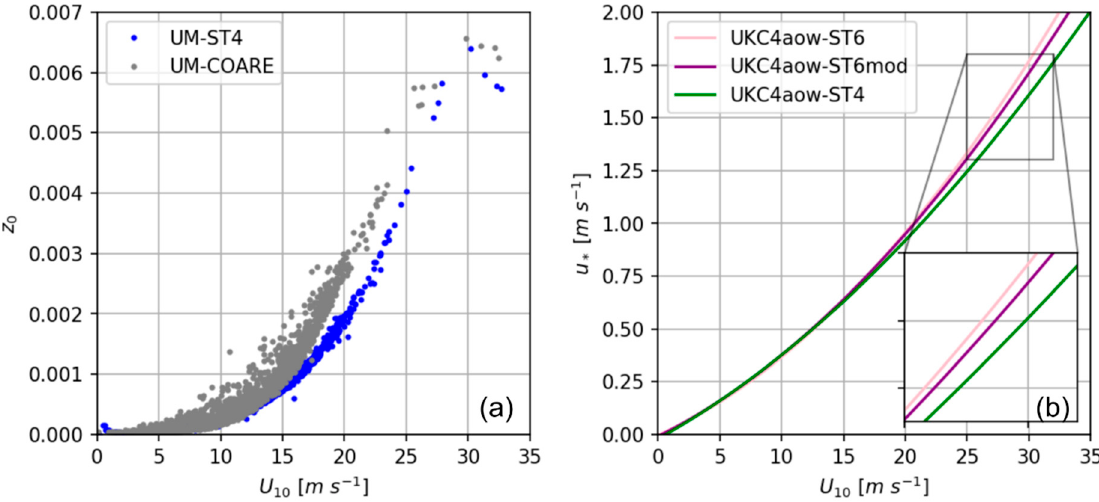
Figure 10. ( a ) Wave height dependent sea-surface roughness z 0 versus wind speed U 10 . ( b ) Friction velocity u ∗ versus wind speed U 10 .